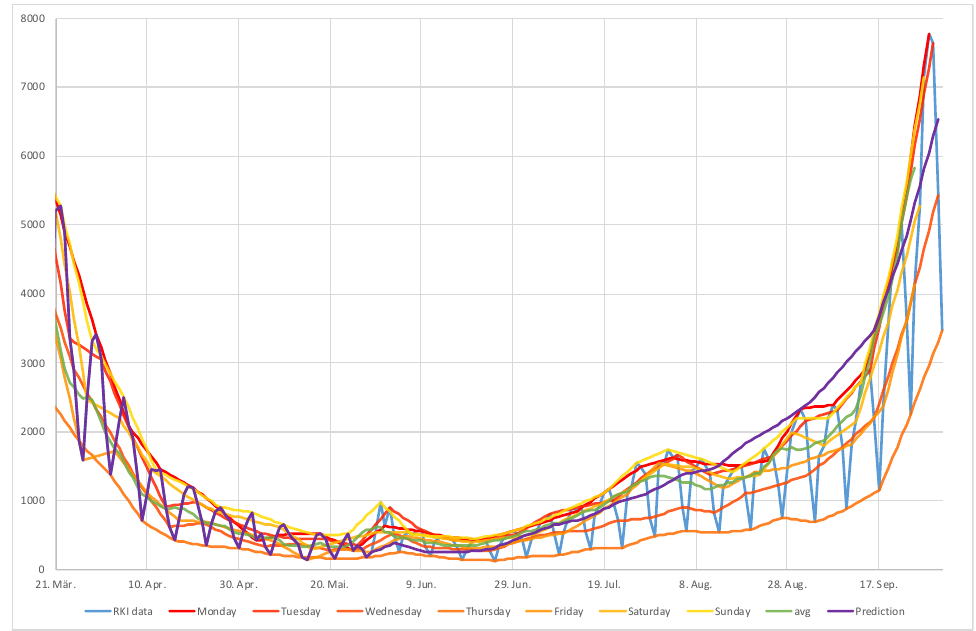
Figure 10. Predicted number of infections in Germany, the interpolation made for each day of the week compared, and the observed data from the RKI.